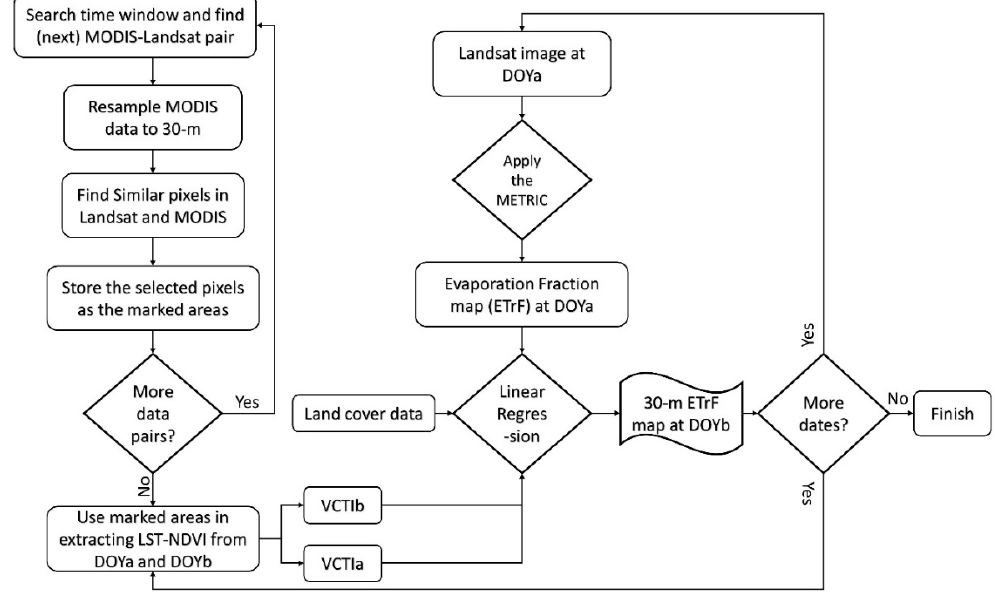
Figure 5. Schematic view of the algorithm used for the Landsat–MODIS evapotranspiration (ET) fusion.